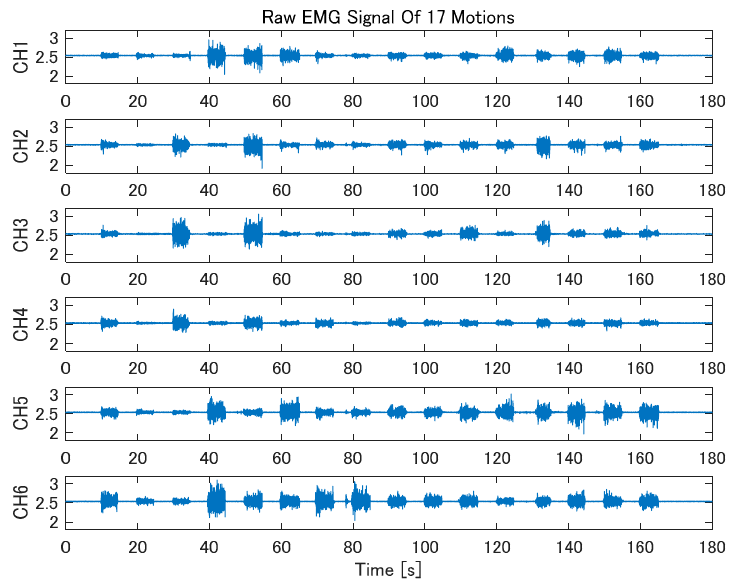
Figure 5. An example of raw EMG (rEMG) signal during the execution of 17 motions. The channels are layout in ascending order starting from the